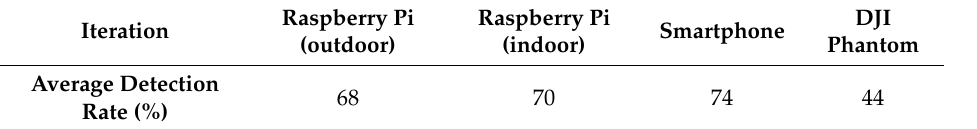
Table 7. Average success rate per test scenario, considering distances up to 10 m. Raspberry Pi Iteration